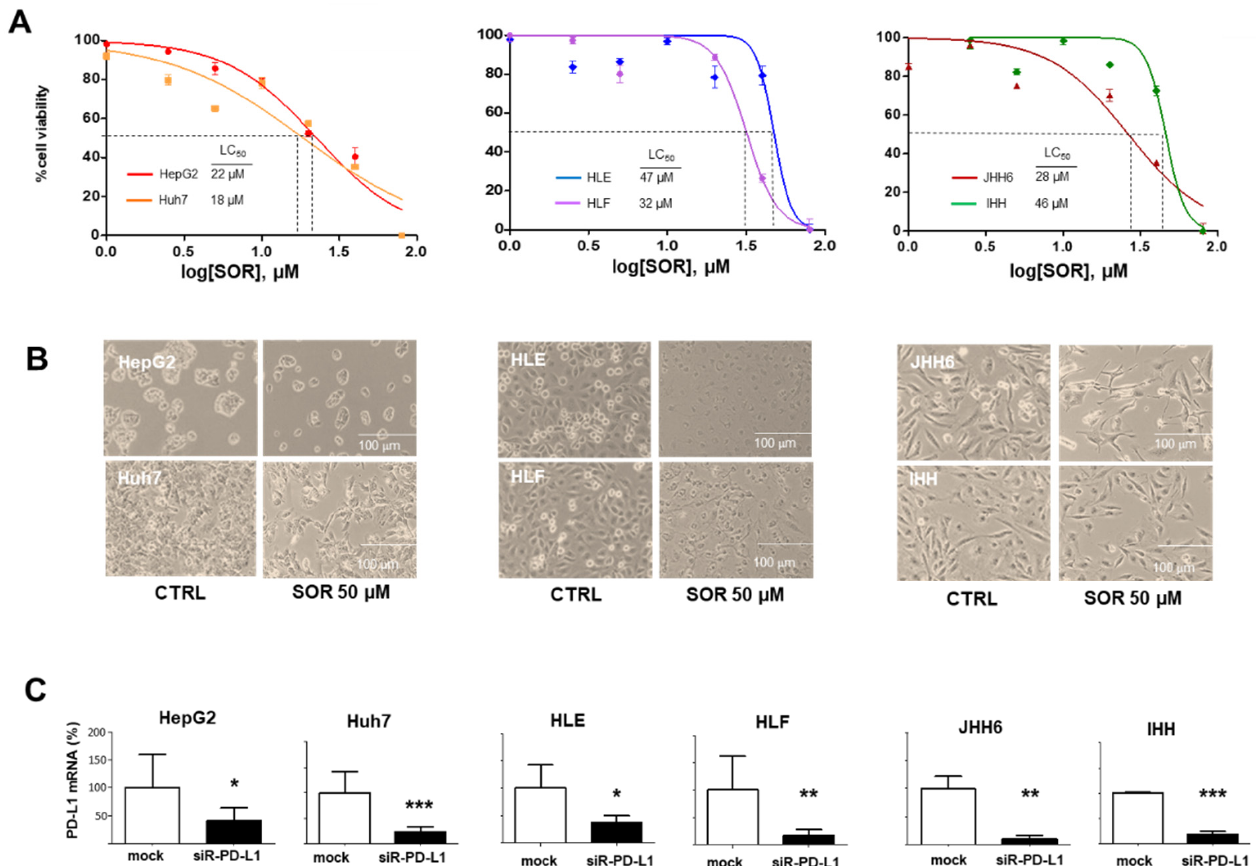
Figure 3. The Sorafenib and PD-L1 mRNA silencing treatments in in vitro models. ( A ) Cell viability upon 24 h treatment with 1 µ M to 80 µ M of SOR. Dashed lines show the value of LC 50 . ( B ) Cell morphology after 24 h treatment of 50 µ M of SOR. ( C ) Down-regulation of PD-L1 mRNA expression after 48 h of 20 nM PD-L1 silencing. Graphs presented as mean ± SD calculated from at least three independent experiments. Statistical analysis: * p < 0.05, ** p < 0.01, *** p < 0.001 using Student’s t -test (vs. mock) in each cell line. SOR: Sorafenib, siR-PD-L1: PD-L1 silencing.